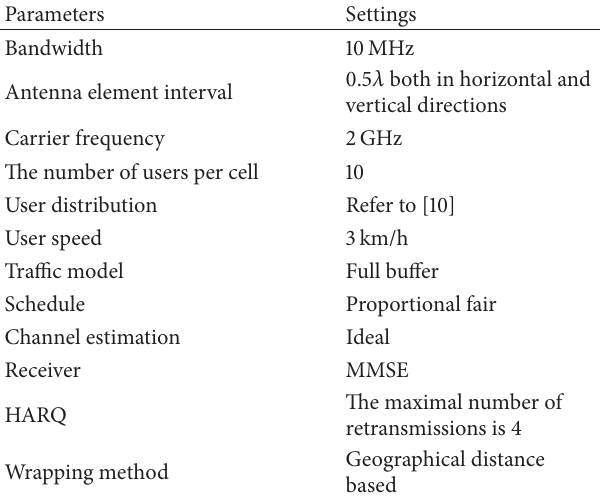
Table 1: Simulation parameters